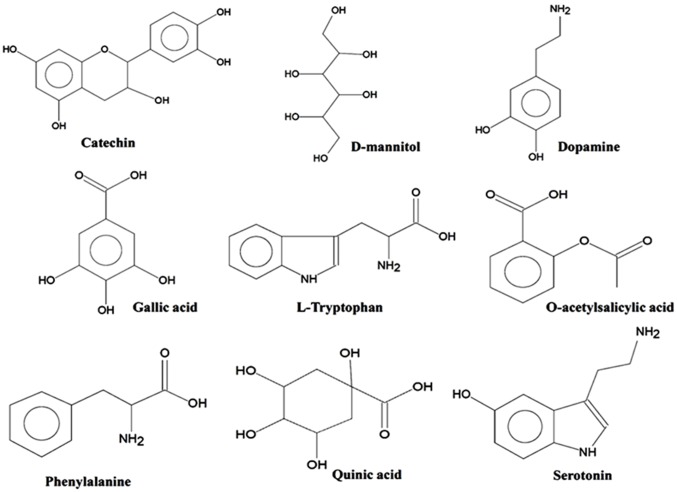
Chemical structures of some essential bioactive metabolites identified in ACL extract by GC-MS.